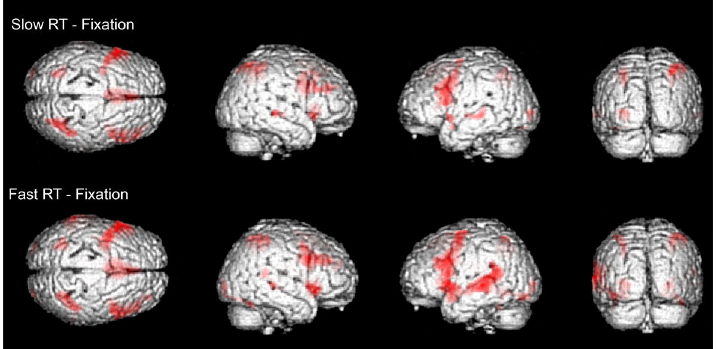
Figure 5. Slow RT and fast RT compared to